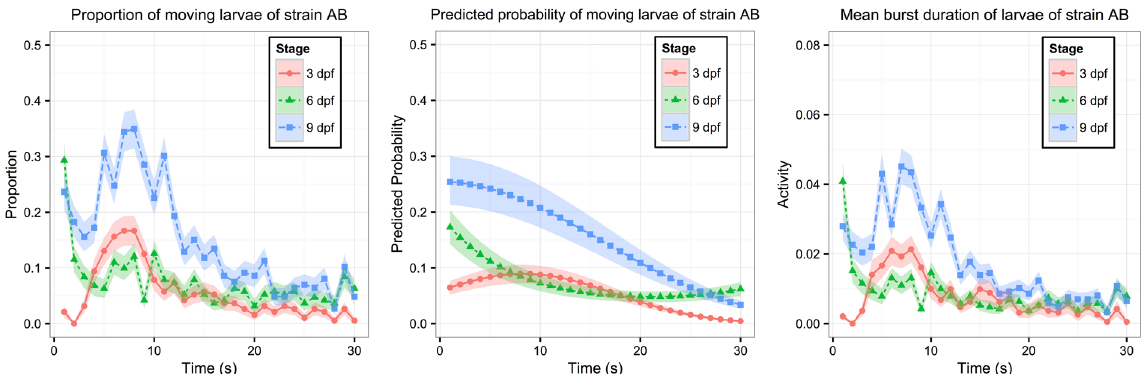
Figure 3. Plots of VMR during the first 30 seconds of Light-On stimulus for AB larvae at 3, 6 and 9 dpf. Left panel: Proportions of moving larvae summarized from the data. Y-axis is the proportion of moving larvae and x-axis is time (1–30s). For different stages, the proportions are shown in different colours. The corresponding ribbon represents 1 standard error from the proportion. Middle panel: Predicted probability of moving larvae. Y-axis is the predicted probability of detecting a moving zebrafish larva and x-axis is time (1–30s). The predicted probability is shown in a different colour for each strain. The corresponding ribbons are the lower and upper quartiles. Note that the Y-axes of left and middle panels are the proportion and predicted probability of moving larvae respectively, which can be derived from the LOA defined as . Right panel: Mean Burst Duration of zebrafish larvae during the same time interval. For each stage, its corresponding ribbon represents 1 standard error from the mean activity. These data were used for the Hotelling’s T-squared tests that are reproduced in Table 5. The sample size in this example is 39900 (3 dpf: 5760; 4 dpf: 5760; 5 dpf: 5760; 6 dpf: 5730; 7 dpf: 5670; 8 dpf: 5640; 9 dpf: 5580).